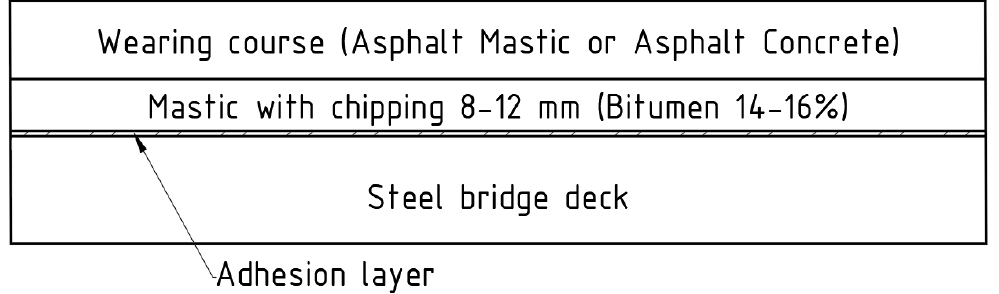
Figure 6. Pavement with a bitumen mastic layer laid on the bonding coat according to Stosch.